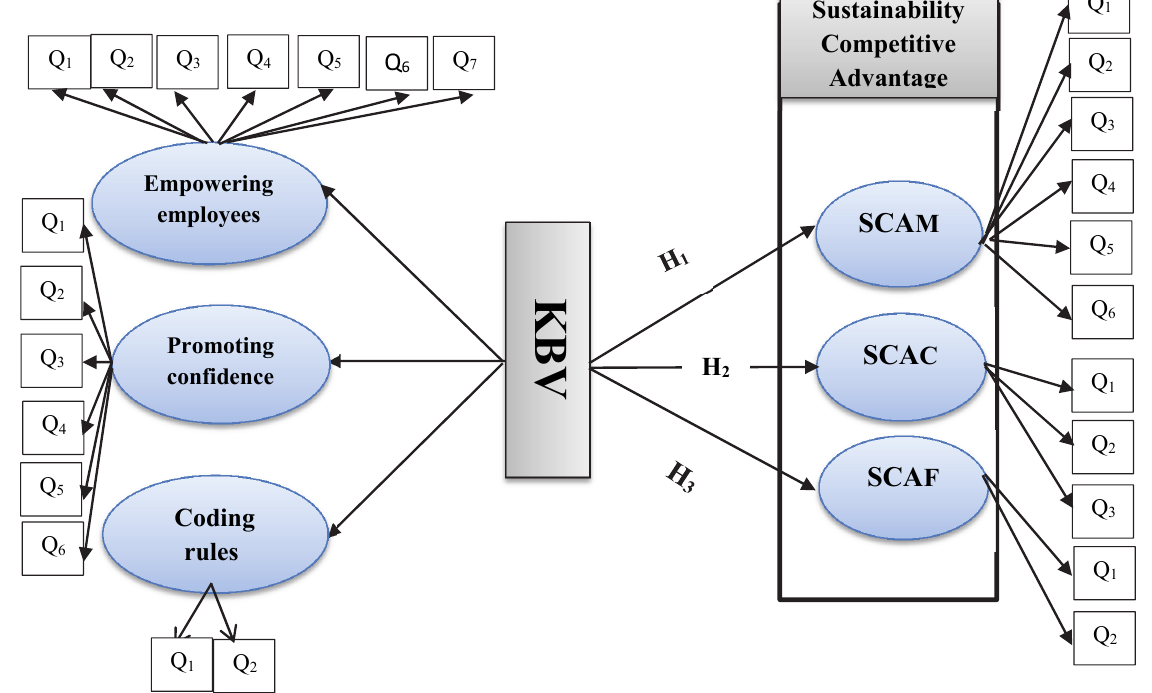
Fig. 1. Conceptual model between KBV and